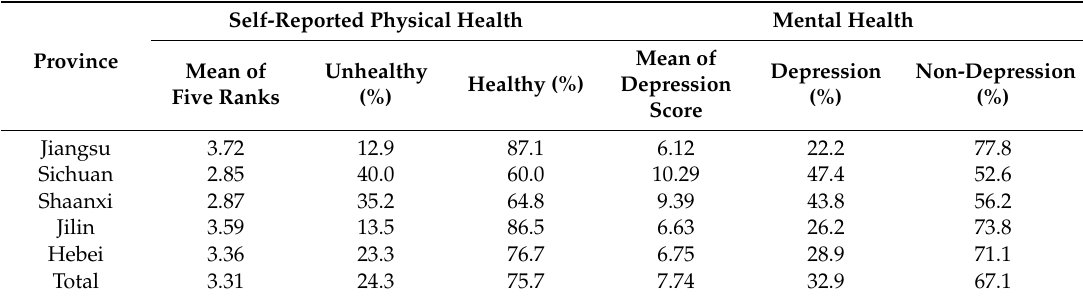
Table 2. Physical and mental health of the rural